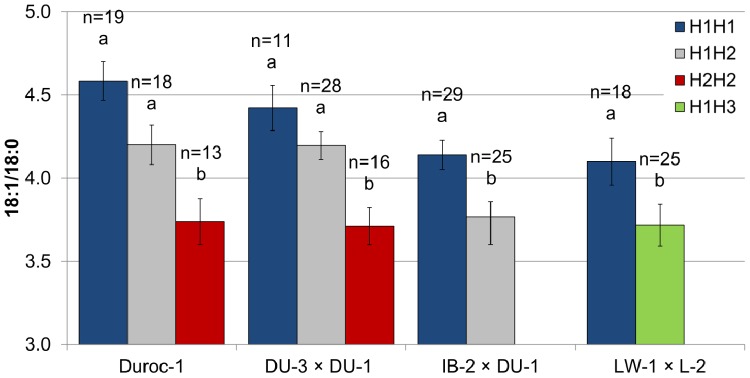
Desaturation ratio by SCD diplotype in experimental crossbreds.The effect of SCD haplotypes on the 18∶1/18∶0 ratio was validated in three experimental genetic types. Sows from the investigated Duroc line (Duroc-1), which was used as control, were sired by boars from an independent Duroc line (DU-3 × DU-1) and by Iberian boars (IB-2 × DU-1), and their progeny contemporarily compared with Large White × Landrace barrows (LW-1 × L-2). The results confirmed that the H1 haplotype increased the 18∶1/18∶0 ratio in the gluteus medius muscle in all genetic types. The H1H1 pigs showed a higher desaturation ratio than H2H2 (0.81 more in Duroc-1 and and 0.61 more in DU-3 × DU-1), H1H2 (0.37 more in IB-2 × DU-1), and H1H3 (0.38 more in LW-1 × L-2) pigs. All LW-1 × L-2 pigs were AA for SNP g.2281A>G, thereby excluding this SNP as a causative mutation. Error bars represent standard errors. Columns lacking a common letter within genetic type differ (p<0.05).